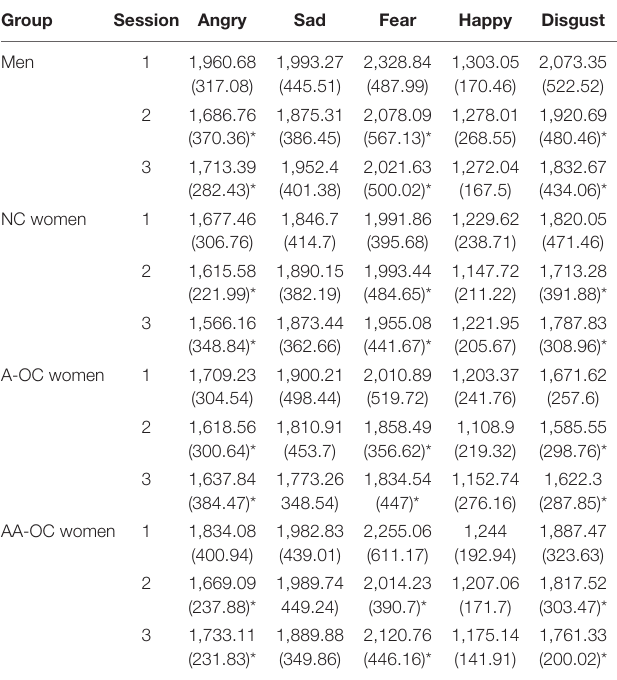
TABLE 1 | Reaction time for emotion